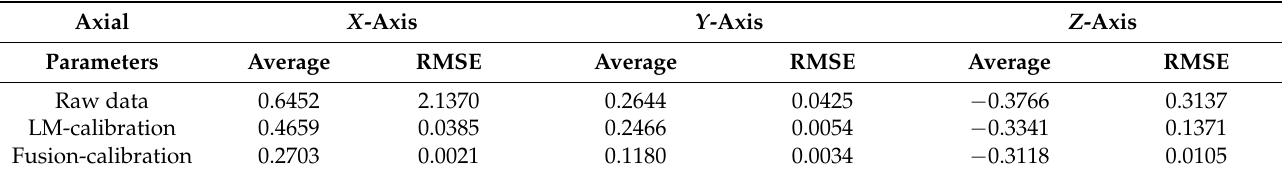
Table 8. MEMS0 gyroscope performance parameter ratio